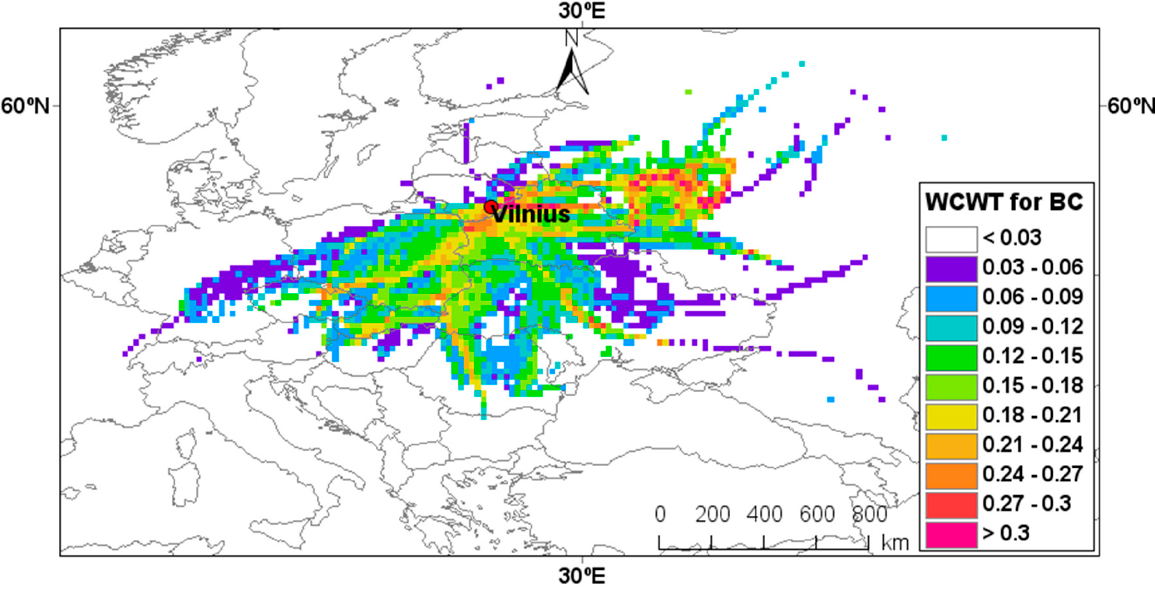
Figure 9. Weighted potential source contribution function of BC in Vilnius in January and February 2014.